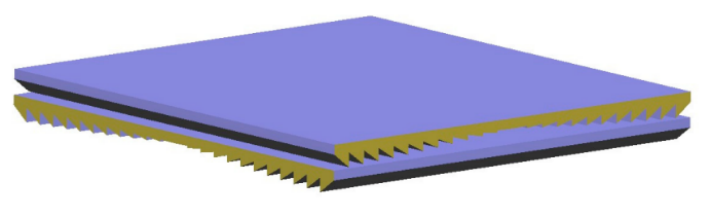
Figure 12. The Fresnel lens with two groove surfaces proposed by Pham et al. [20]. The perpendicular lines are clearly shown on the lower and middle surfaces. Reprinted from Thanh T. Pham et al., Novel Design of Primary Optical Elements Based on a Linear Fresnel Lens for Concentrator Photovoltaic Technology, Energies 2019, 12, 1209, with permission from